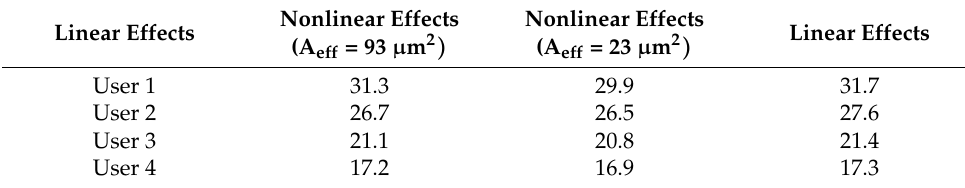
Table 5. Q-factor (dB) for the four